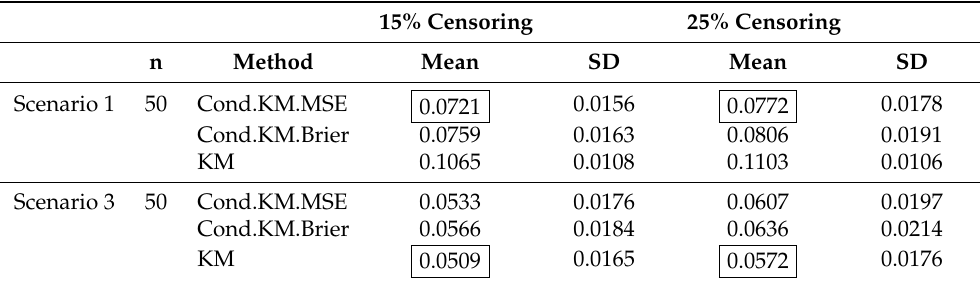
Table A1. The MSPEs of the survival probability in the test data using conditional functional KM, regular KM, and FLCRM for scenario 1 with sample size